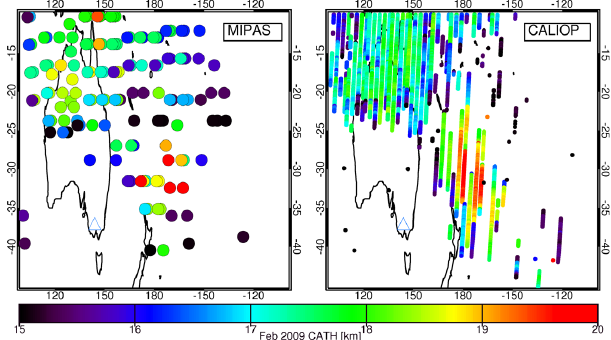
Fig. 10. Comparison of MIPAS and CALIOP CATH (nighttime data for both datasets) from 7 February to 16 February 2009 over Aus- tralia and New Zealand. The blue triangle indicates the position of Victoria (located at 38 ◦ S, 143 ◦ E) where the Black Saturday bush- fires originated.